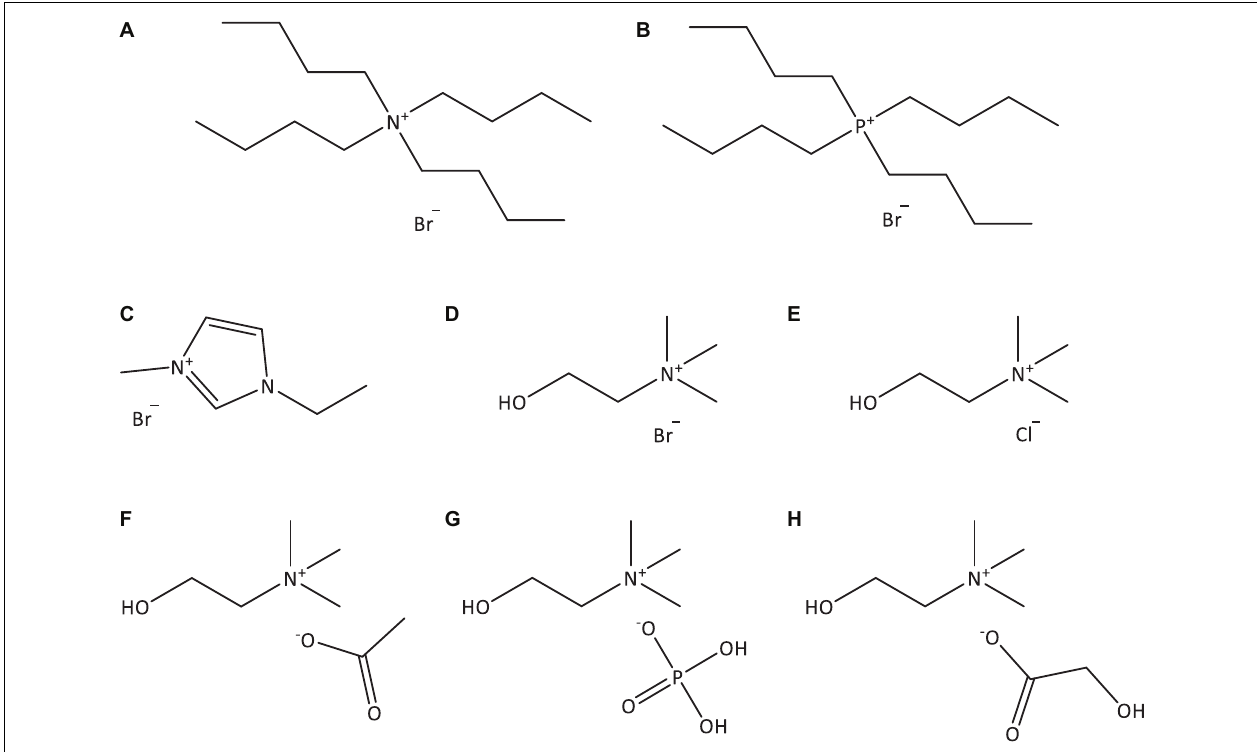
FIGURE 1 | Chemical structures of the ILs used in this work: (A) [N 4444 ]Br; (B) [P 4444 ]Br; (C) [C 2 C 1 im]Br; (D) [N 111 ( 2 OH ) ]Br; (E) [N 111 ( 2 OH ) ]Cl; (F) [N 111 ( 2 OH ) ][Ac]; (G) [N 111 ( 2 OH ) ][DHP]; (H) [N 111 ( 2 OH )